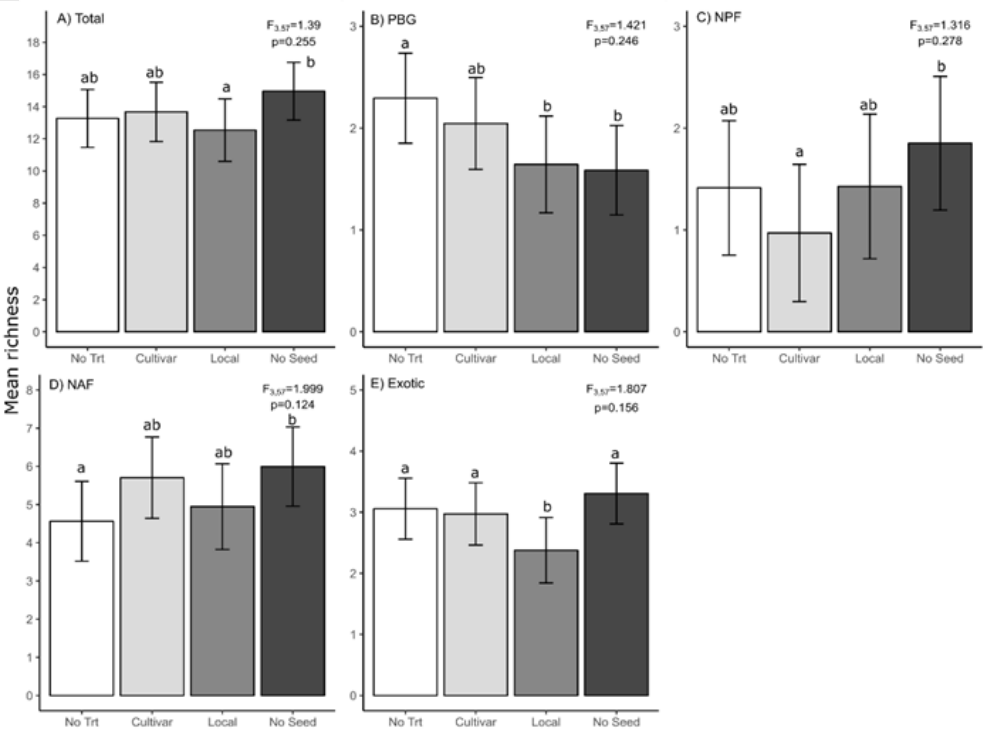
Figure 7. Skid trail functional group mean richness by seeding treatment in 2017: least square means, 95% confidence intervals and ANOVA p -values. Lowercase letters denote significance among treatments (post-hoc contrasts, p < 0.10). All perennial bunchgrasses (PBG), native perennial forbs (NPF), native annual forbs (NAF), all exotics (Exotic). ( A ) Total, Total plant cover; ( B ) PBG, Perennial large bunchgrasses; ( C ) NPF, Perennial Forbs; ( D ) NAF, Native annuals; ( E ) Exotic, all